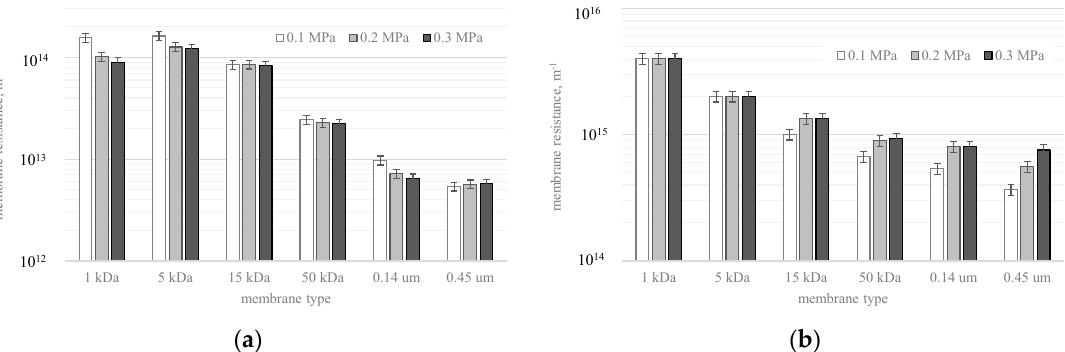
Figure 8. Total flow resistance changes during filtration of redistilled water ( a ) and digestate liquid fraction ( b ) at different TMP.